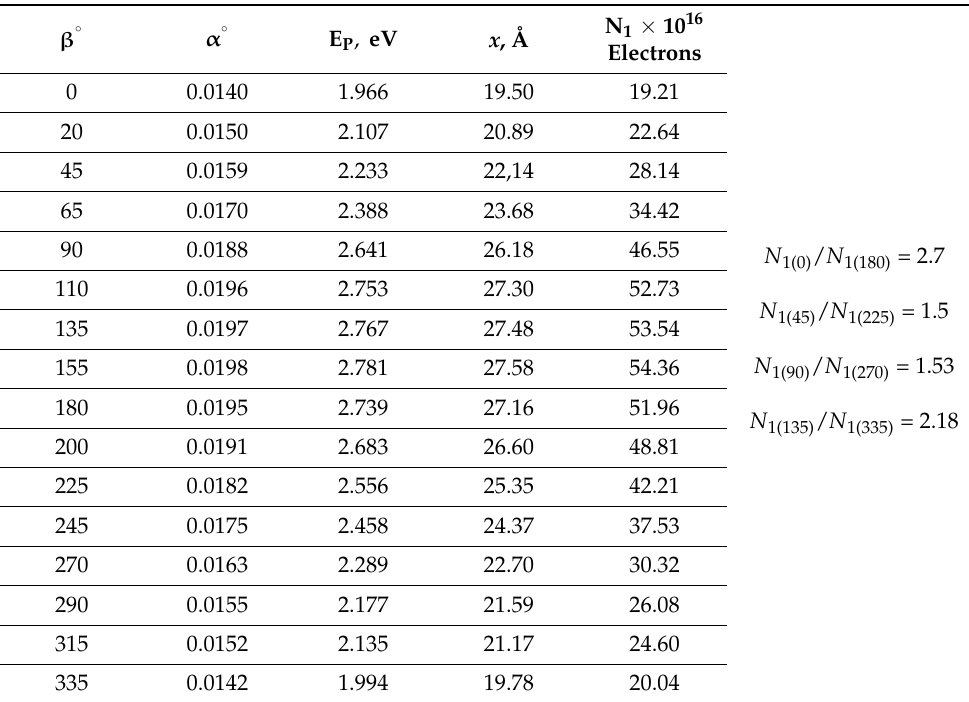
Table 8. Experimental and calculated data for vanadium dioxide № 2. β